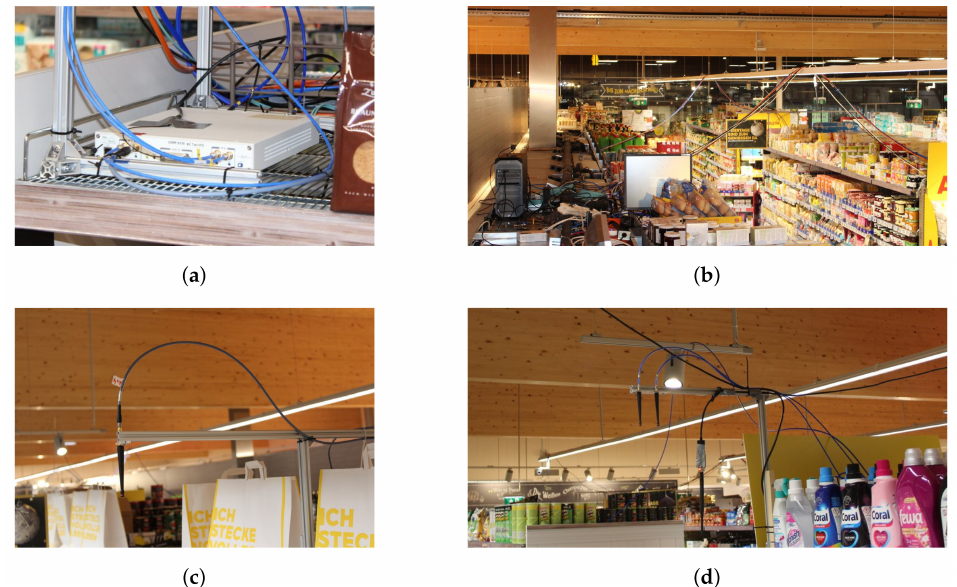
Figure 4. Measurement setup components mounted in the test environment. ( a ) USRP #2 mounted on the top of a shelf. ( b ) Overview over the covered area. Visible are the host setup, the nodes on the shelves of aisle 1, and the cable harnesses to USRP #2 (foreground) and #3 (background). ( c ) Anchor 3. ( d ) Anchor